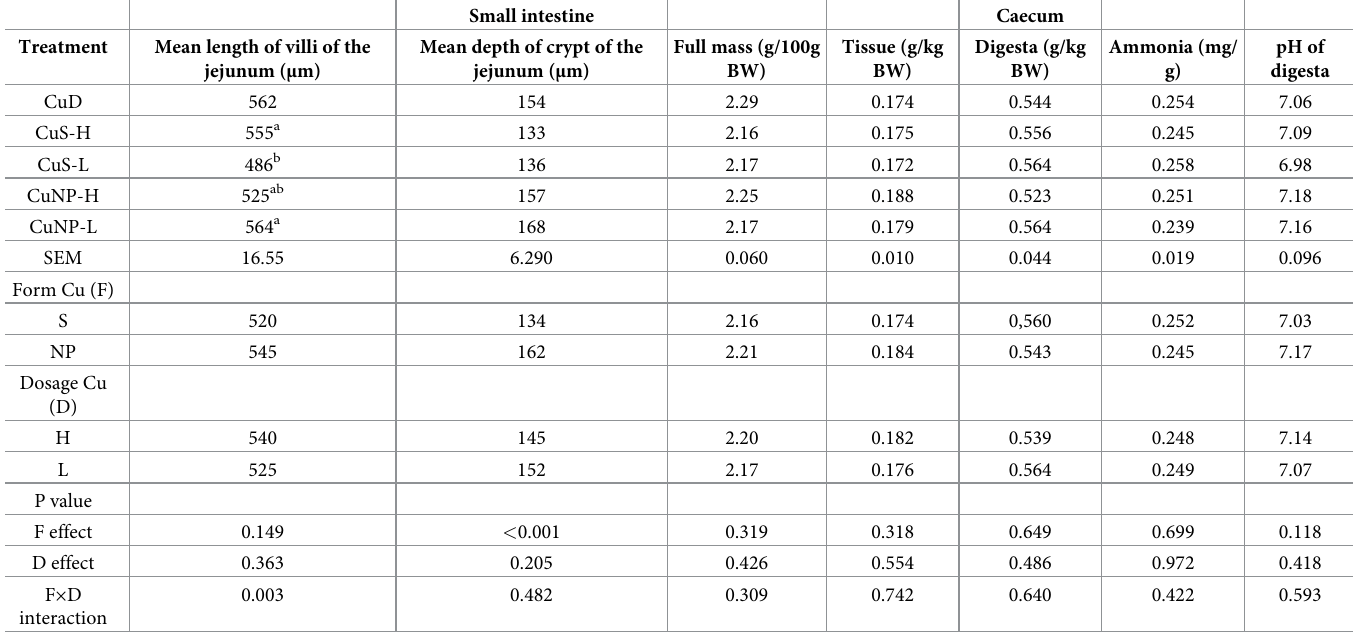
Table 9. The relative weight of small intestine with contents, measurements of jejunal villi and crypts in experimental rats as well as basic caecal indices.